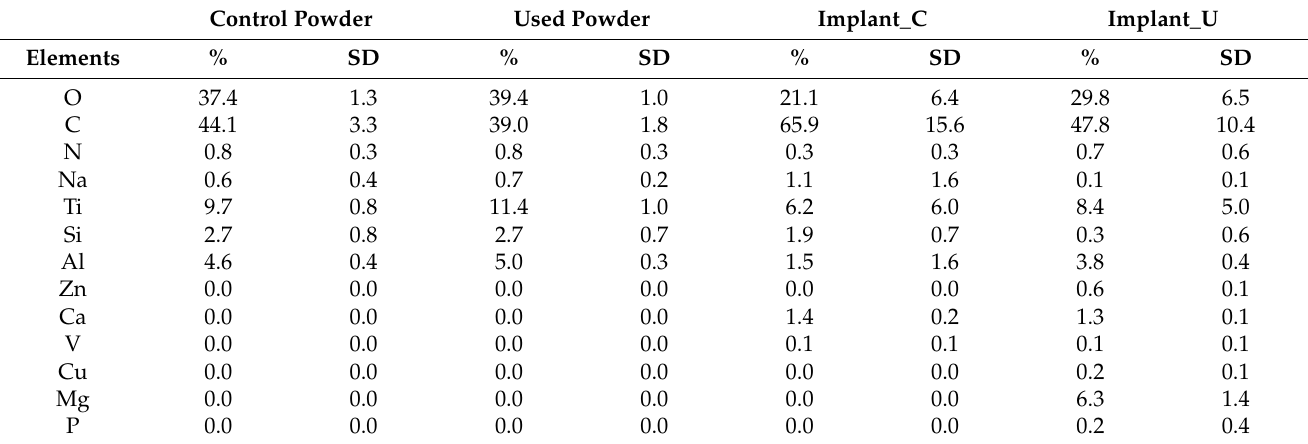
Table 1. Atomic percentage and standard deviation of the tested samples at the surface (0 nm). Control Powder Used Powder